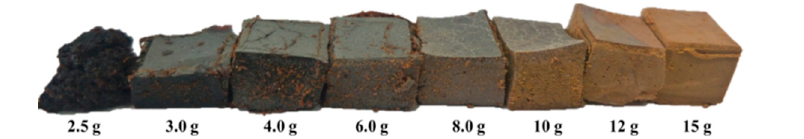
Figure 1. Picture of bio-based polysulfides prepared with different sulfur content.